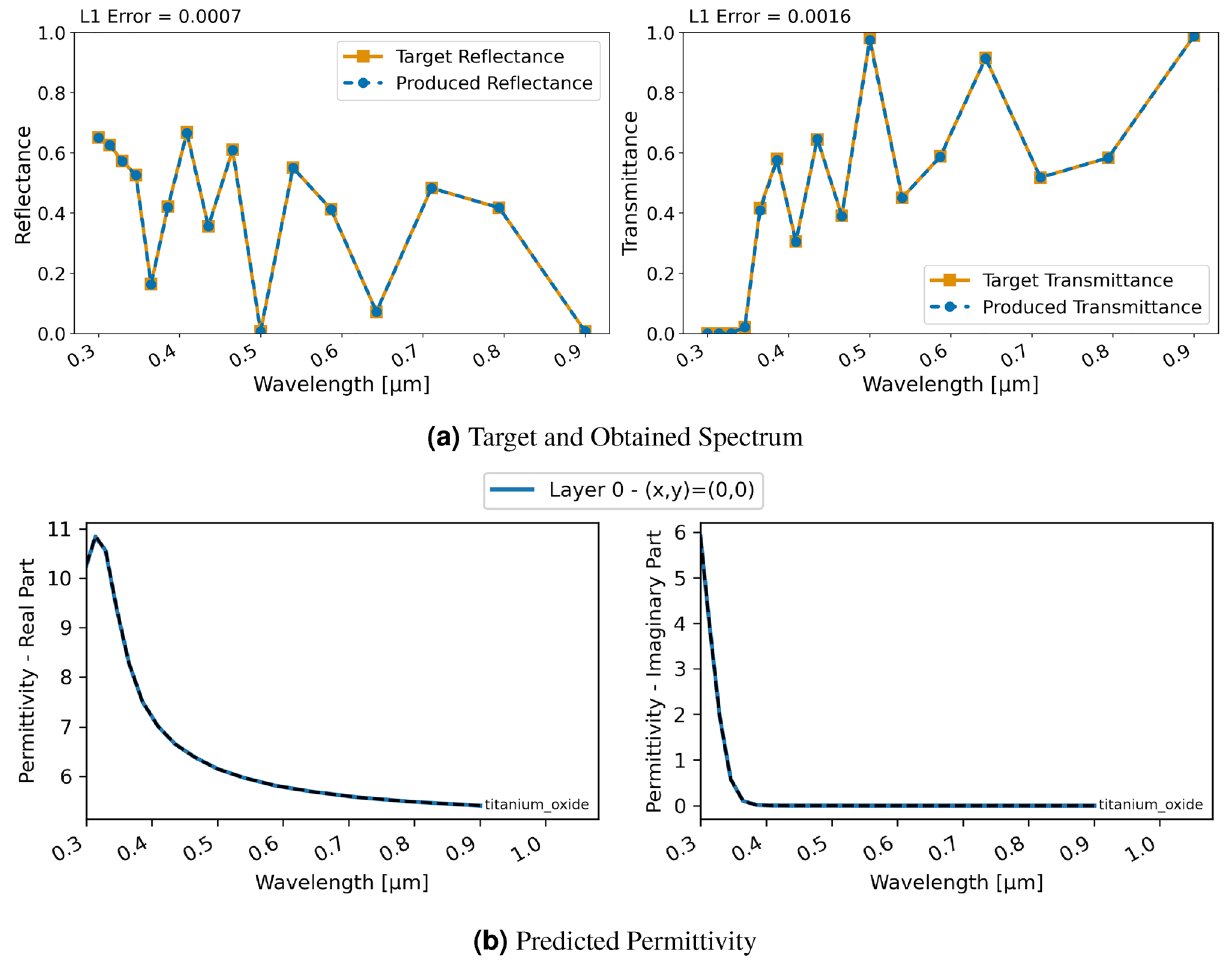
Figure 4. Inversion results for a single-layer TiO 2 material using FDTD and classification; ( a ) displays